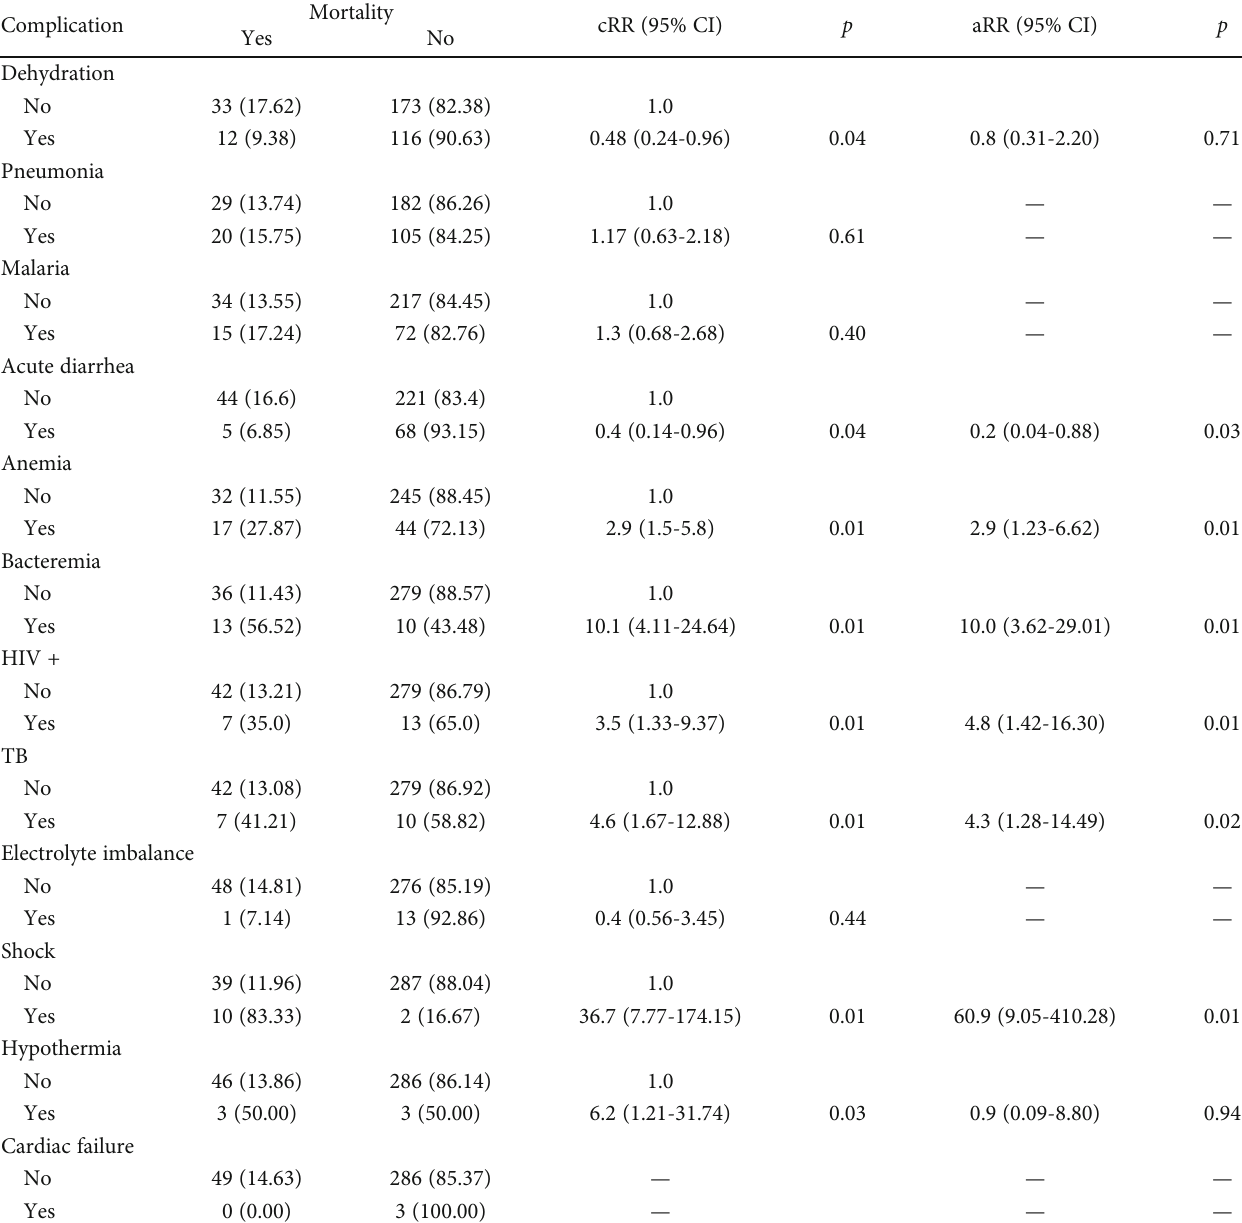
Table 2: Comorbidities associated with mortality among children below 5 years with severe acute malnutrition in JRRH.